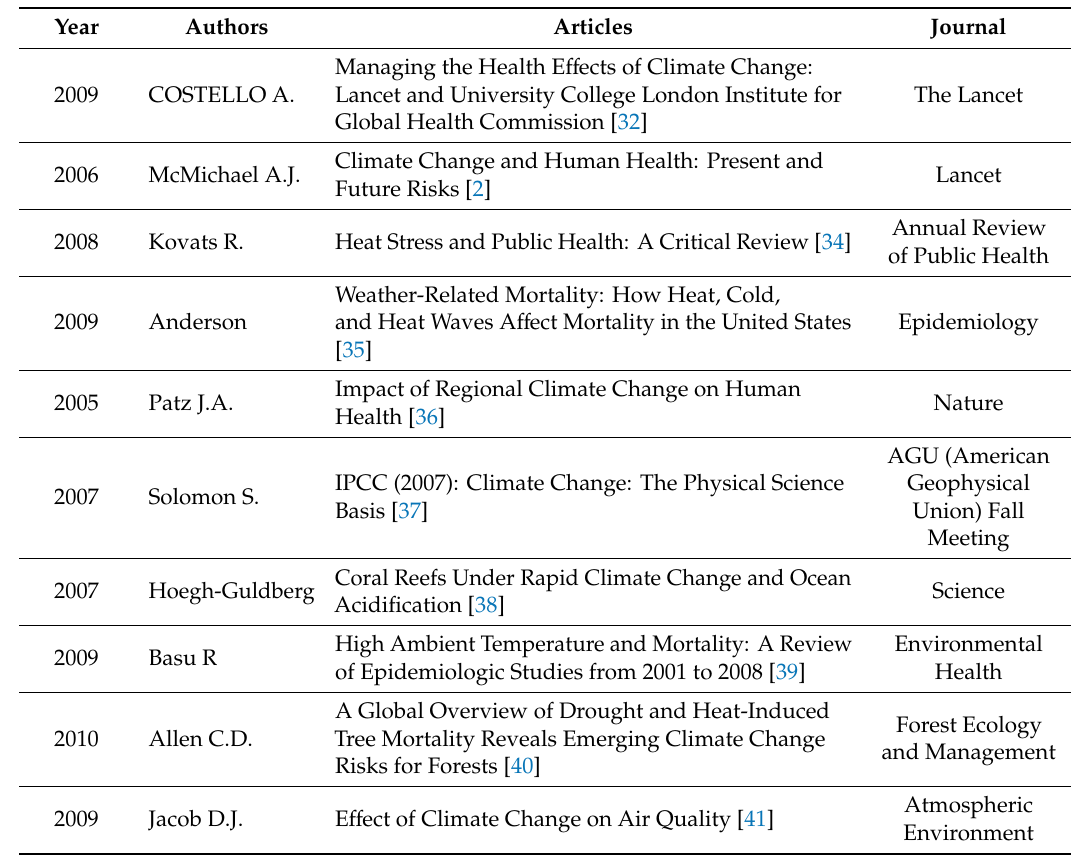
Table 5. Literature citation frequency ranking.